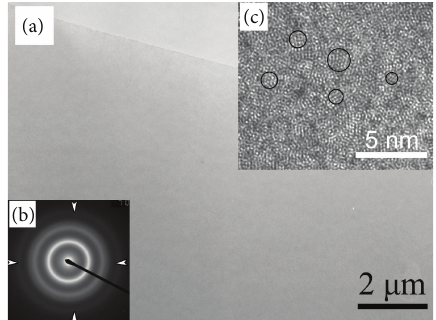
Figure 3: The microstructure of the Pd 81 Si 19 BMG: (a) a bright field (BF) image, (b) a selected-area electron diffraction (SAED) pattern, and (c) a HRTEM image.